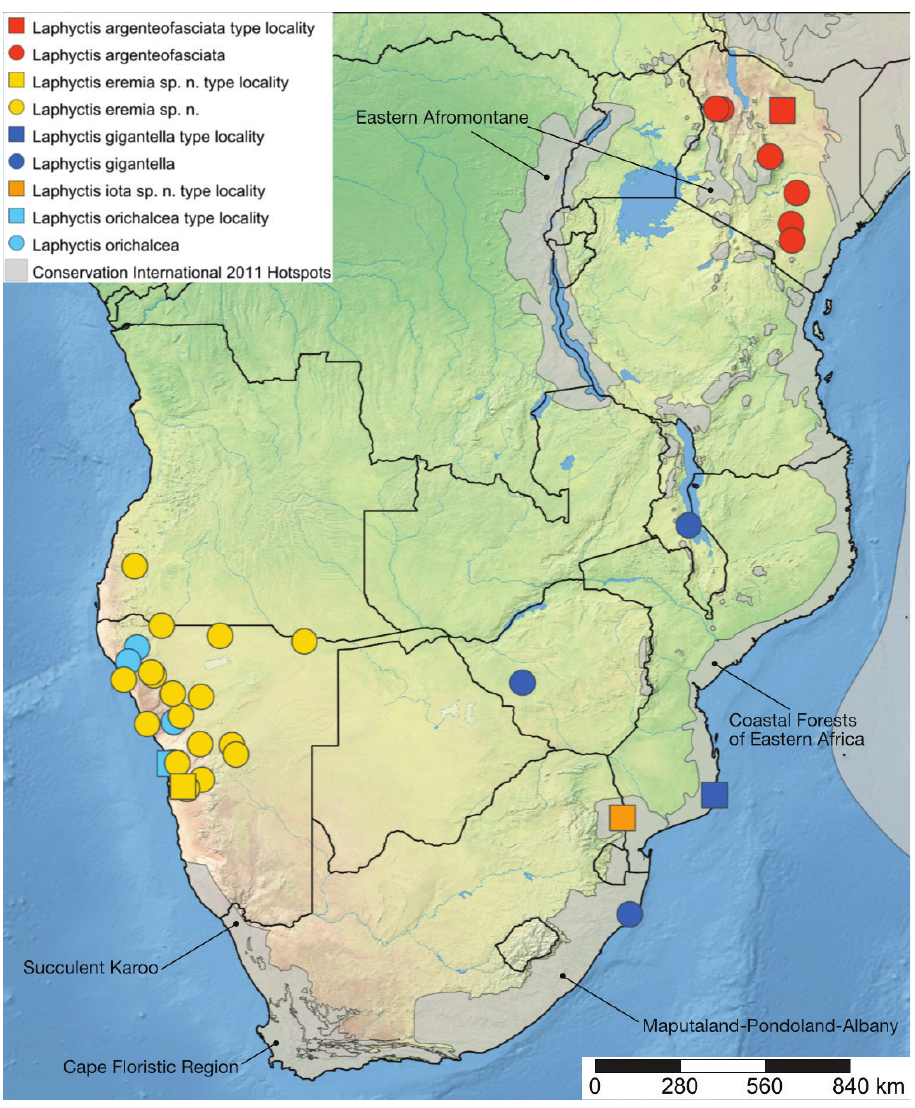
Figure 56. Map of sub-Saharan Africa with elevational relief, Biodiversity Hotspots ( sensu Conserva- tion International), and distribution of Laphyctis species (SimpleMappr 9287). Laphyctis sp. (NSMA- DIP-07858) shares the same locality as Laphyctis gigantella in western Zimbabwe.